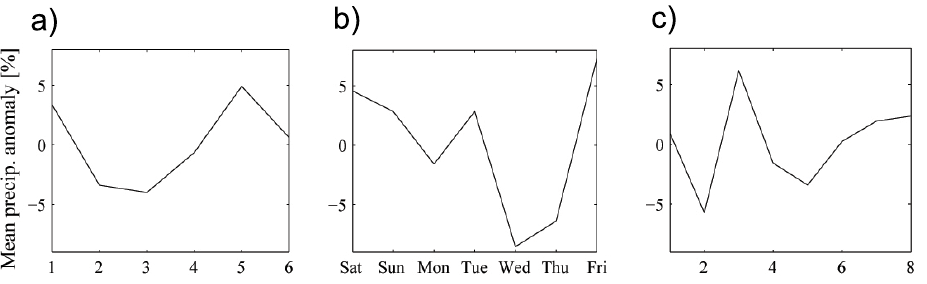
Fig. 8. Weekly cycles of regional mean (average of the 30 stations in the Black Triangle) precipitation anomaly for 1983–2008, for (a) constructed 6-day weeks, (c) the actual 7-day weeks, and (c) constructed 8-day weeks.